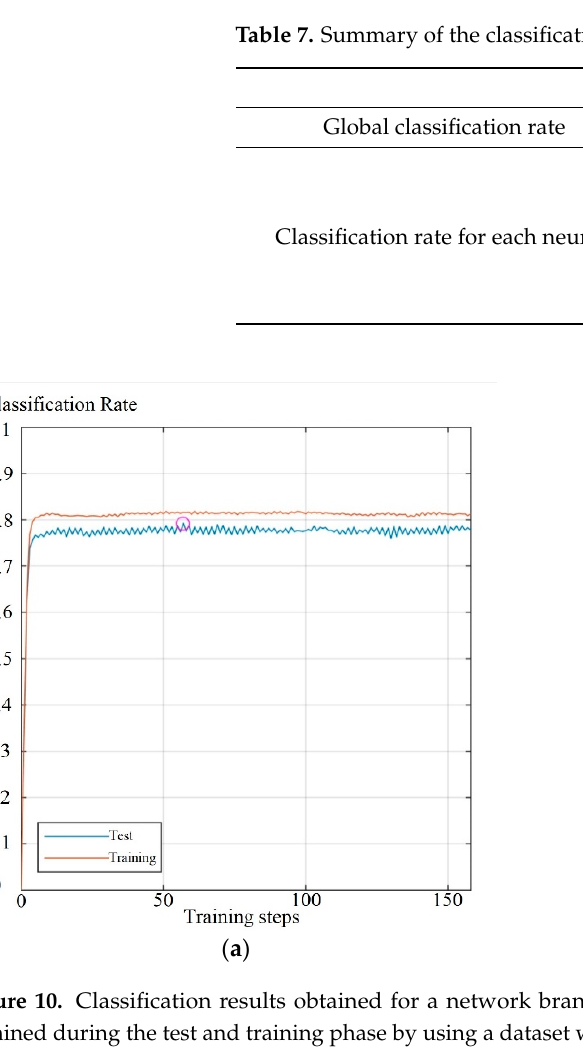
Table 8. Summary of the classification results obtained for four cable